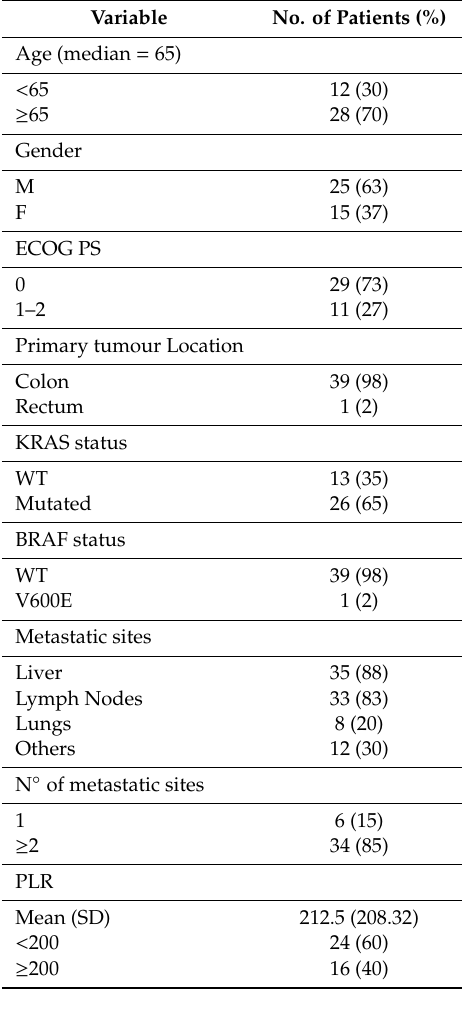
Table A1. Clinicopathological characteristics of all 40 patients